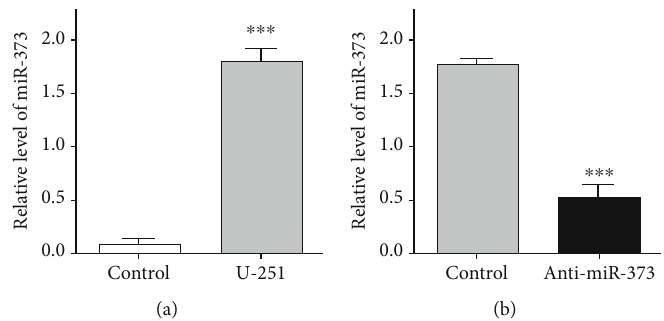
Figure 1: miR-373 level in U-251 cells. (a) High miR-373 level was observed by real-time quantitative PCR in U-251 cells. (b) miR-373 level was reduced obviously after anti-miR-373 transfection by real-time quantitative PCR in U-251 cells (bars indicate the standard deviation of the mean; each experiment was performed in triplicate; ∗∗∗ p < 0 : 001